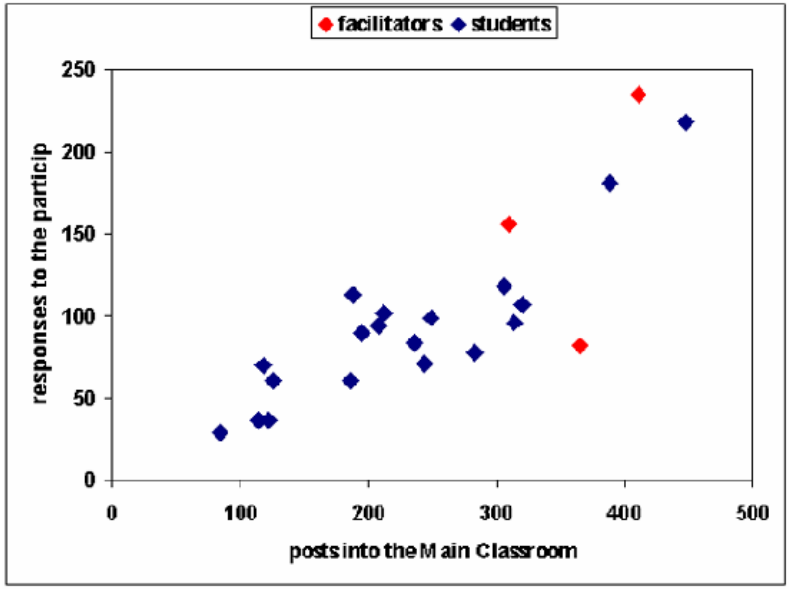
Figure 8. Number of messages posted into the main classroom by individuals, and responses to the individuals. The data represents the entire